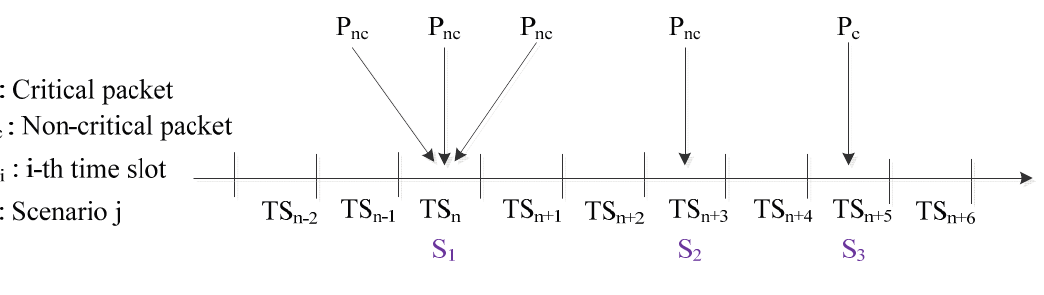
Figure 2. Successful packet transmission in